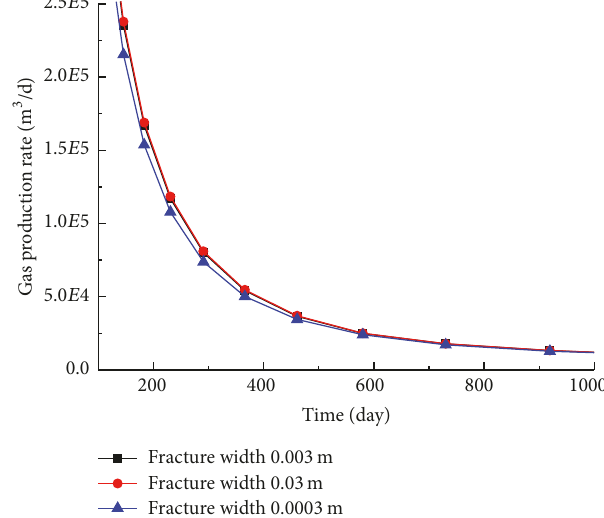
Figure 8: Effect of fracture width on gas production